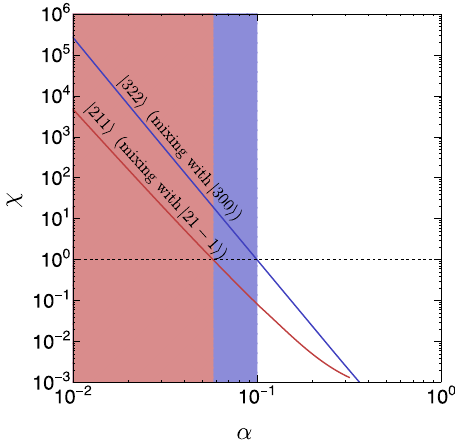
Fig.7|Evaluationofthestabilityofthesuperradiantcloudinthepresenceofa stellar halo. Colored lines: perturbation estimator χ , de fi ned in Eq. (11), for the dominant mixings between different superradiant and decaying levels, induced by astellarhalowitha m pert =2harmonicperturbationinitsdensitypro fi leasspeci fi ed by Eq. (16). Red and blue lines correspond to mixings of the ∣ 211 i and ∣ 322 i levels with decaying levels, respectively. Colored regions: values of the gravitational parameter α for which the perturbation estimatoris χ >1 for the shownmixings, in which case the corresponding clouds are unstable against the stellar halo